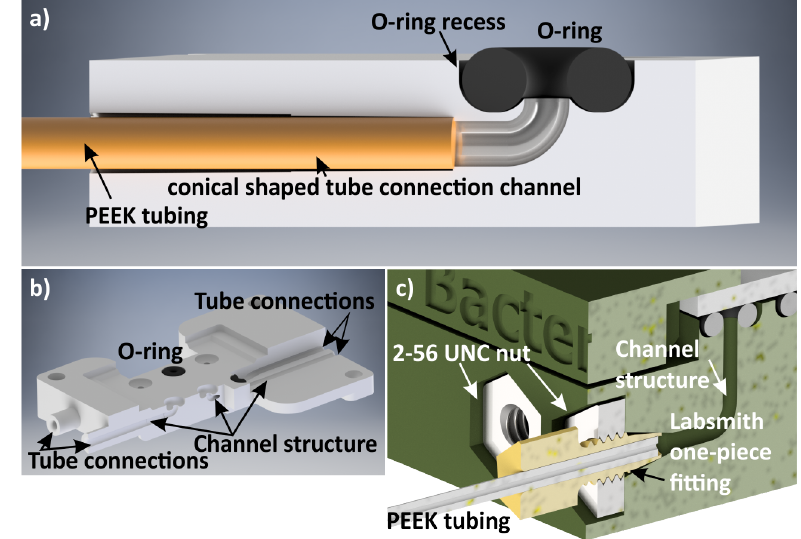
Figure 3. Methods to realize the fluidic connection between microfluidic chips and syringe pumps. ( a ) A schematic of an O-ring positioned in a recess and a tube fitted in a conically-shaped channel geometry; ( b ) a 3D rendered image visualizing the inner channel geometry; ( c ) a Labsmith one-piece fitting connection integrated in a chip